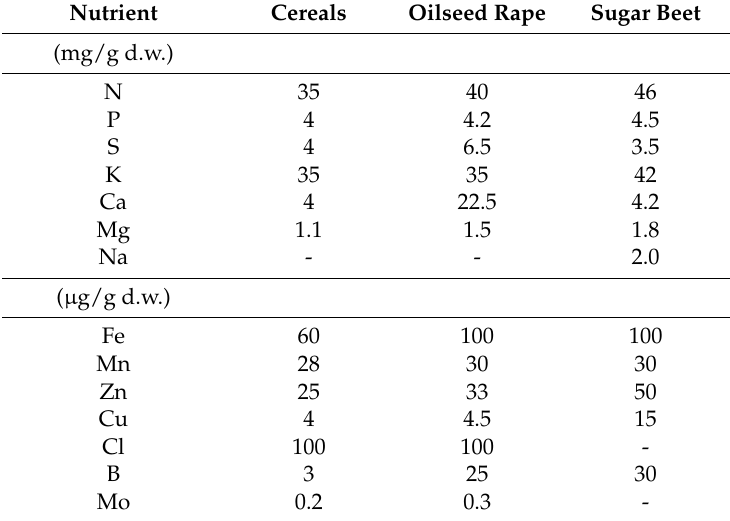
Table 1. No-effect values for essential macro- and micronutrients, and Na concentrations in cereals, oilseed rape, and sugar beet (extracted from